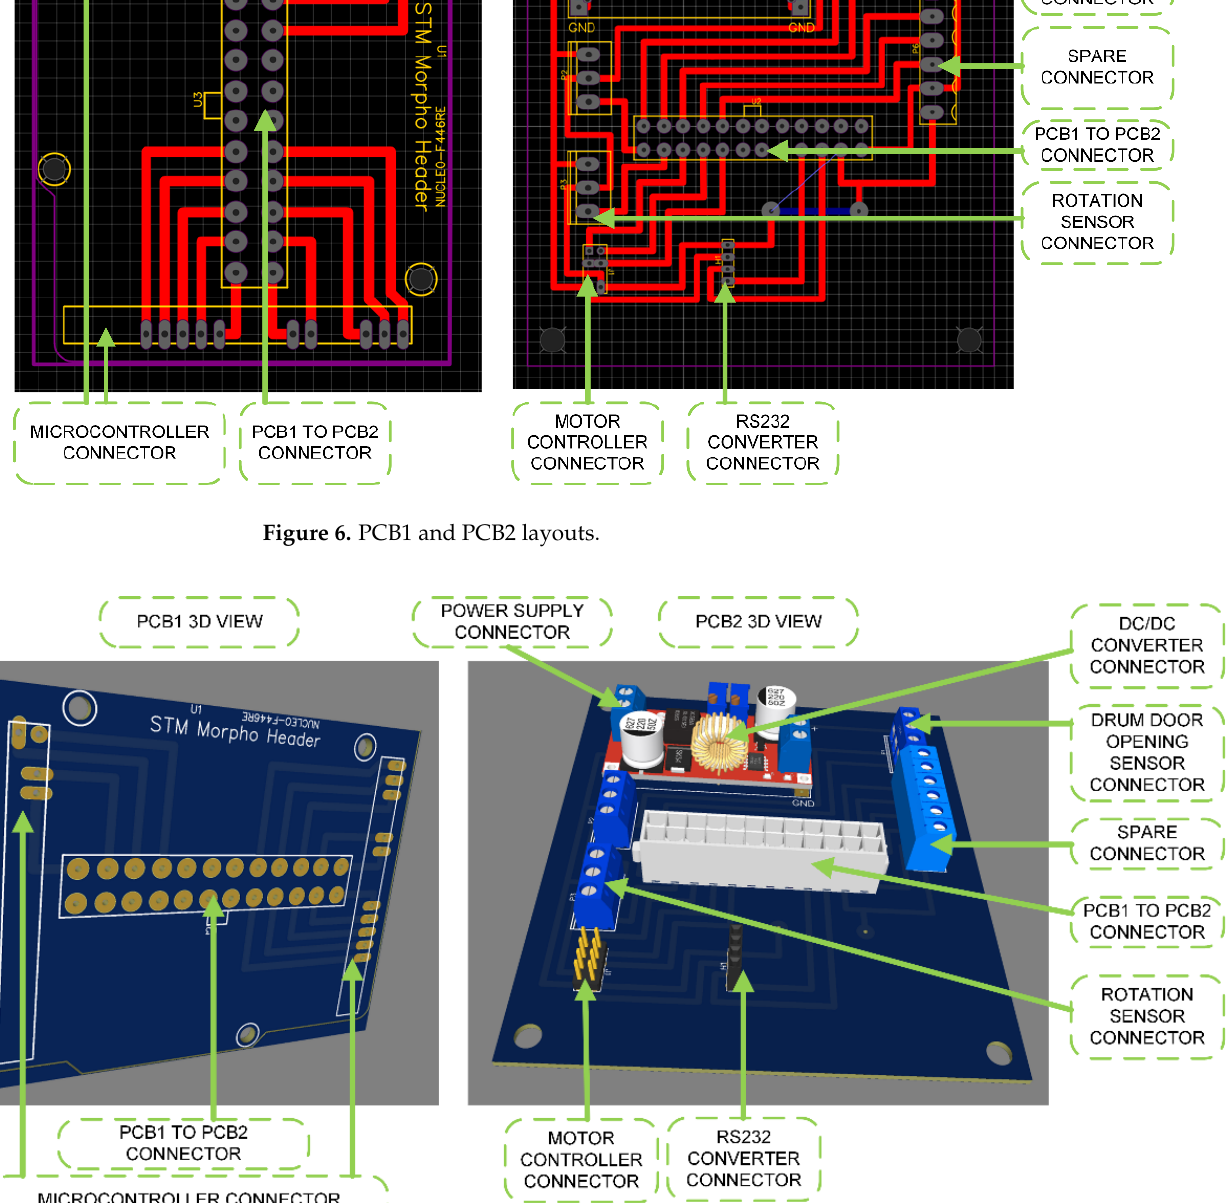
Figure 7. Three ‐ dimensional visualizations of PCB1 and PCB2 boards. Figure 7. Three-dimensional visualizations of PCB1 and PCB2